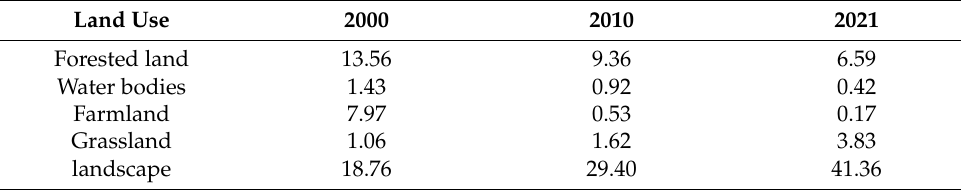
Table 5. LPI values of green space in central Fuzhou during the period 2000, 2010, 2021. Land